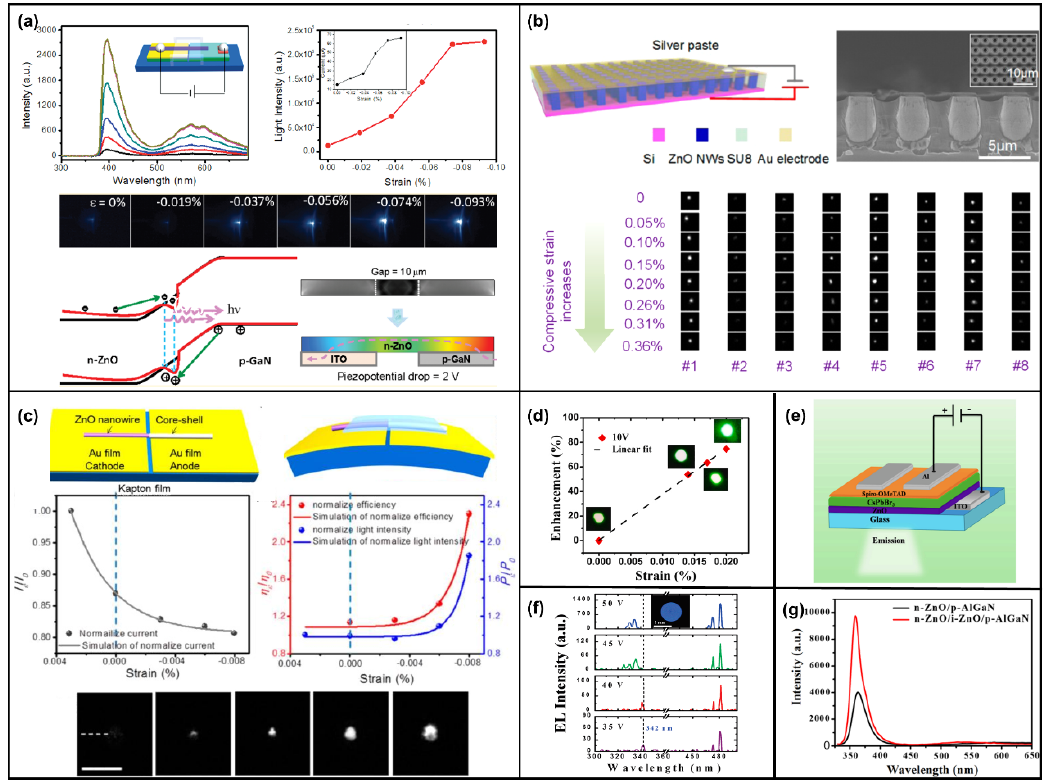
Figure 8. Enhancement in emission light intensity via the piezo-phototronic effect based on ZnO. ( a ) Enhancement in emission light intensity and band diagram of a n-ZnO NW/p-GaN LED under applied strain. Reproduced with permission from [226]. Copyright (2011) Nano Letters . ( b ) Device structure and enhancement in emission light intensity of ZnO-nanofilm/Si-micropillar heterostructure arrays. Reproduced with permission from [229]. Copyright (2016) American Chemical Society Nano. ( c ) Device structure and enhancement in emission light intensity of a ZnO NW/p-polymer CS UV LED. Reproduced with permission from [233]. Copyright (2013) Nano Letters . ( d ) The percentage enhancement in the light emission intensity of the fabricated LED under different applied strains up to ~0.02%. ( e ) Schematic representation of ITO/ZnO/CsPbBr 3 /Spiro-OMeTAD/Al heterojunction device configuration for EL measurements. Reproduced with permission from [237]. Copyright (2021) Nano Energy . ( f ) EL spectra recorded from the p-n ZnO NW arrays under various operating voltage conditions at room temperature. The top view photograph of the bright light-emitting spot at 50 V is displayed in the inset figure. The dashed vertical lines located at 342 nm were introduced as a guide for the eye. Reproduced with permission from [239]. Copyright (2010) Nano Letters . ( g ) The room-temperature PL spectra. Reproduced with permission from [238]. Copyright (2018) Applied Physics Letters .